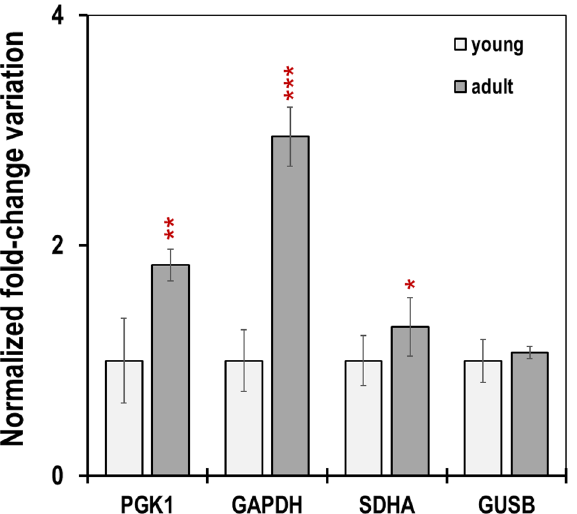
Figure 7. Normalized fold change variation in the expression level of PGK1, GAPDH, SDHA and GUSB in the antler blood (mean ± SEM, n = 5 and n = 10 in the young and adult groups,